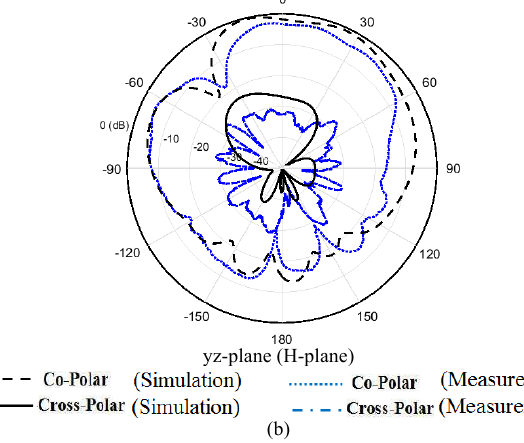
FIGURE 9 . Measurement and simulation results of radiation patterns of the suggested full design with V-shaped slot at (a) 4.5 GHz (b) 10.9 GHz.